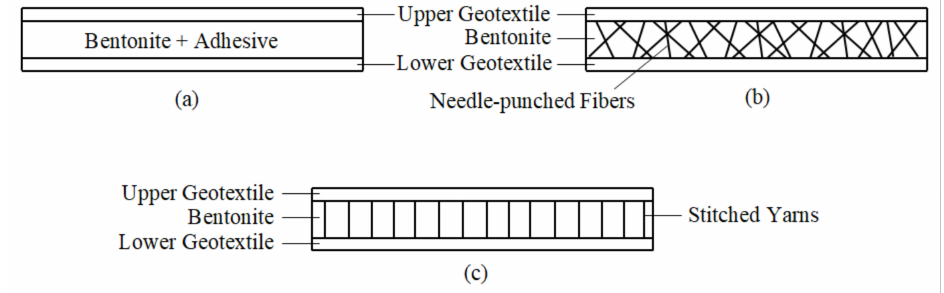
Figure 5. Cross-sectional views of GCL types: ( a ) Adhesive-bonded GCL; ( b ) Needle-punched GCL; ( c ) Stitch-bonded GCL.